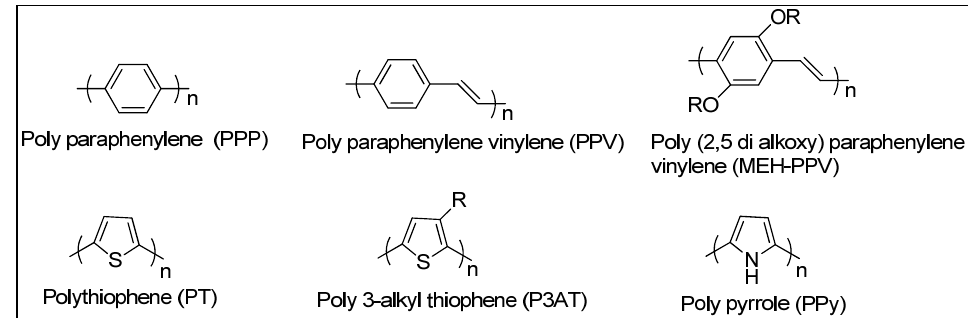
Figure 4. Molecular structures of some important heterocyclic polymers (second generation).